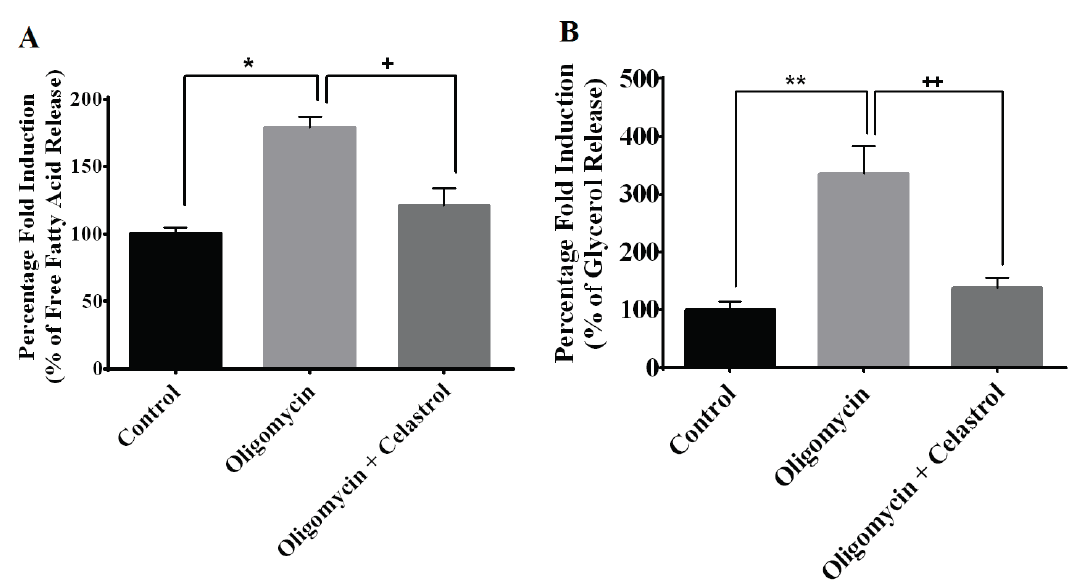
Figure 5. Effects of celastrol treatment on lipolysis and intracellular lipid accumulation of differentiated 3T3-L1 adipocytes with mitochondrial dysfunction. In the presence of MDI, fully differentiated 3T3-L1 adipocytes were incubated with oligomycin and celastrol for 48 h differentiated cells were on analyzed for ( A ) free fatty acids and ( B ) glycerol release as described in materials and methods. The Oil Red O stained adipocytes were photographed at 40× magnification; ( C ) Untreated control (DMSO); ( D ) MDI-treated cells; ( E ) Oligomycin-treated cells and ( F ) Oligomycin + celastrol-treated cells. Figures represent one of three independent experiments; and ( G ) Quantification of intracellular lipid droplets in 3T3-L1 adipocytes treated with oligomycin and celastrol was performed accordingly. The results are representative of those obtained from three independent experiments. All values are presented as means ± SEM of three independent experiments. * p < 0.05 and ** p < 0.01 vs . untreated cells; + p < 0.05 and ++ p < 0.01 vs. oligomycin-treated